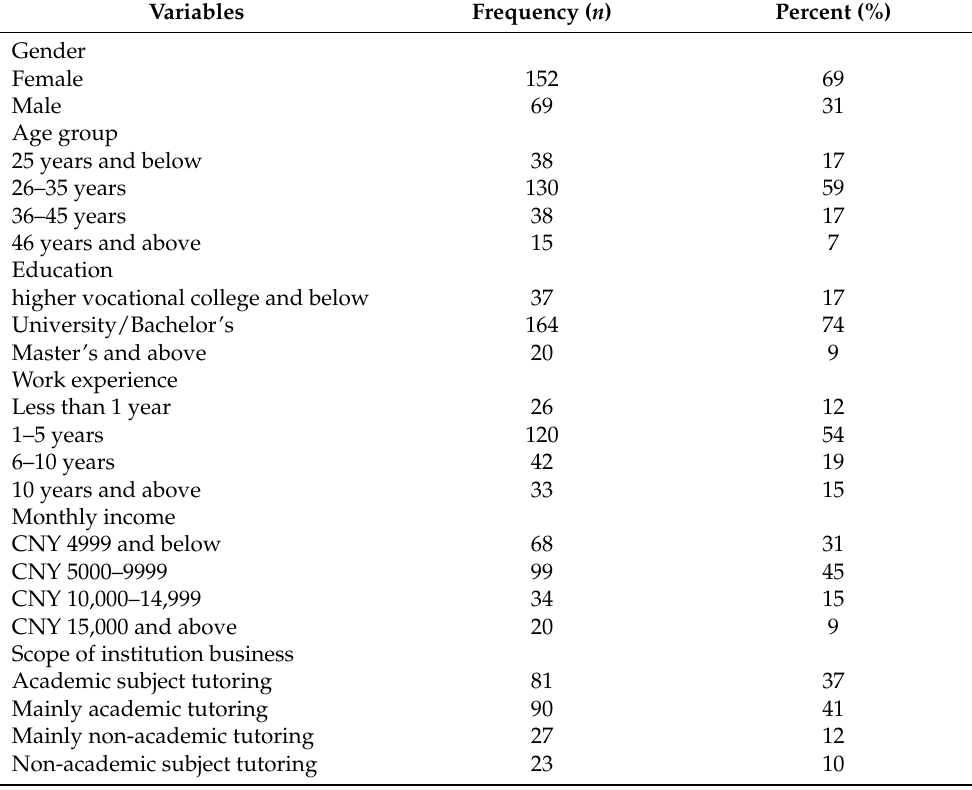
Table 1. Demographic statistics ( N = 221).